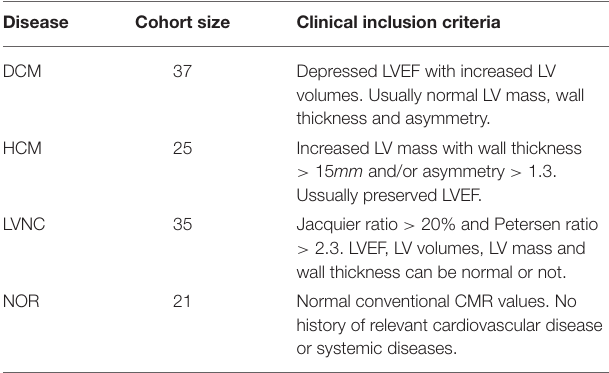
TABLE 1 | Cohort size for each specific disease/control and clinical criteria for inclusion.